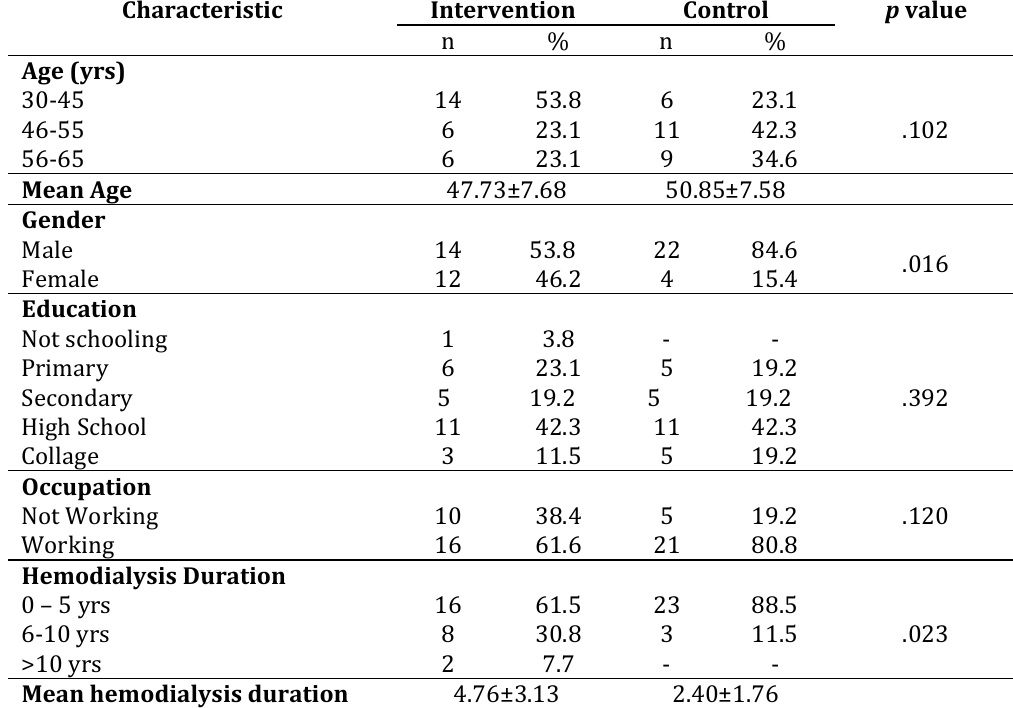
Demographic characteristics of respondents on intervention and control group (n=52)